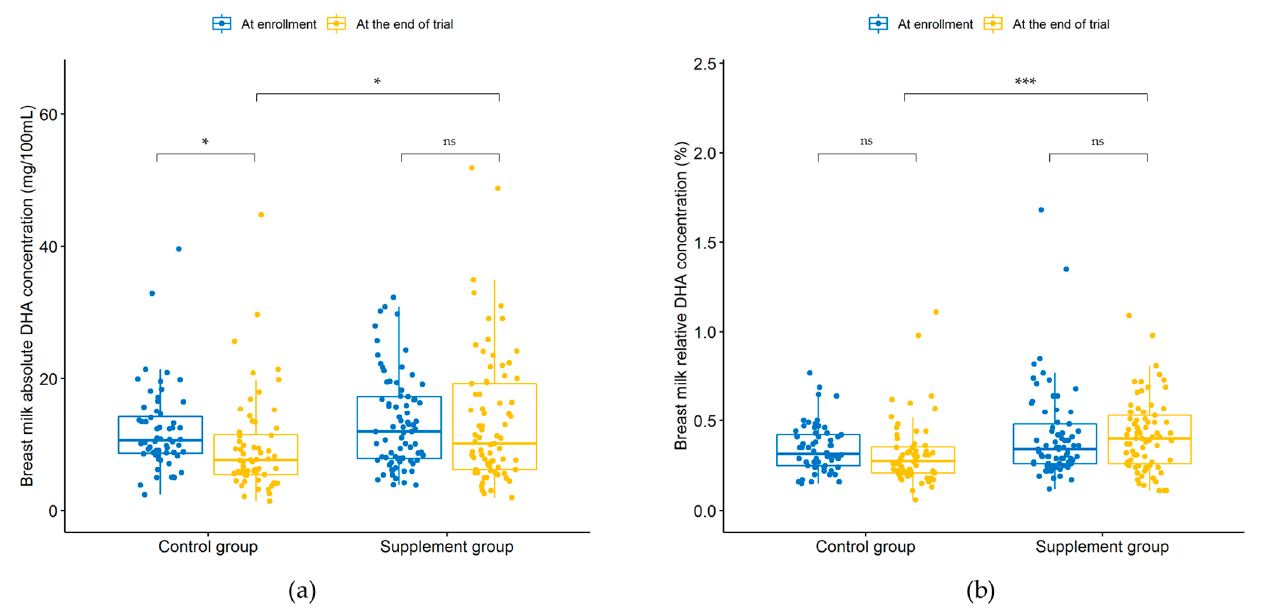
Figure 2. Comparison of the absolute( a ) and relative ( b ) DHA concentrations in breast milk between the control and supplement groups before and after the intervention. ns: p > 0.05, * p < 0.05, *** p < 0.001.